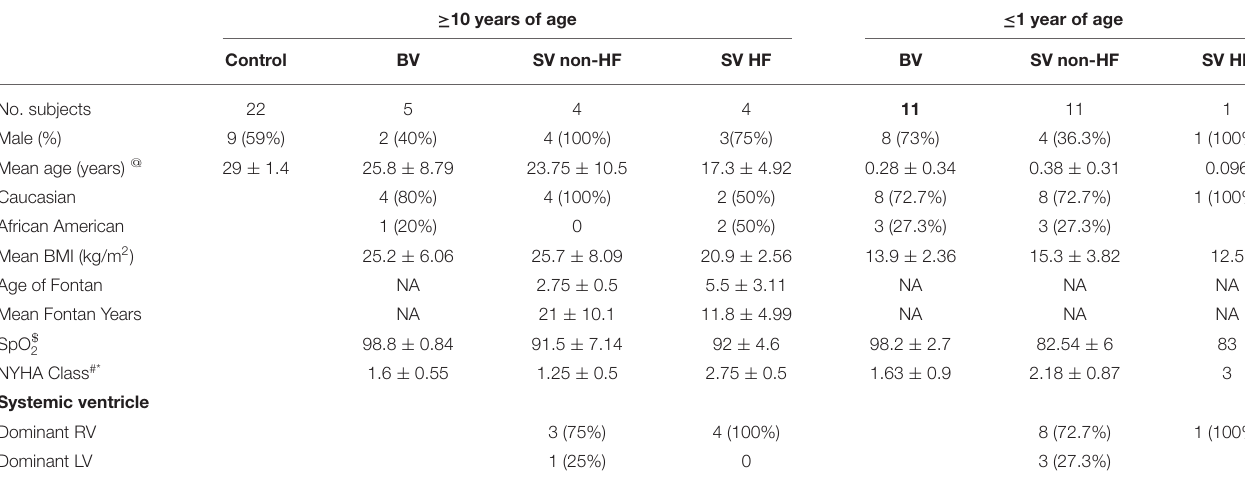
TABLE 1 | Demographic and clinical outcome